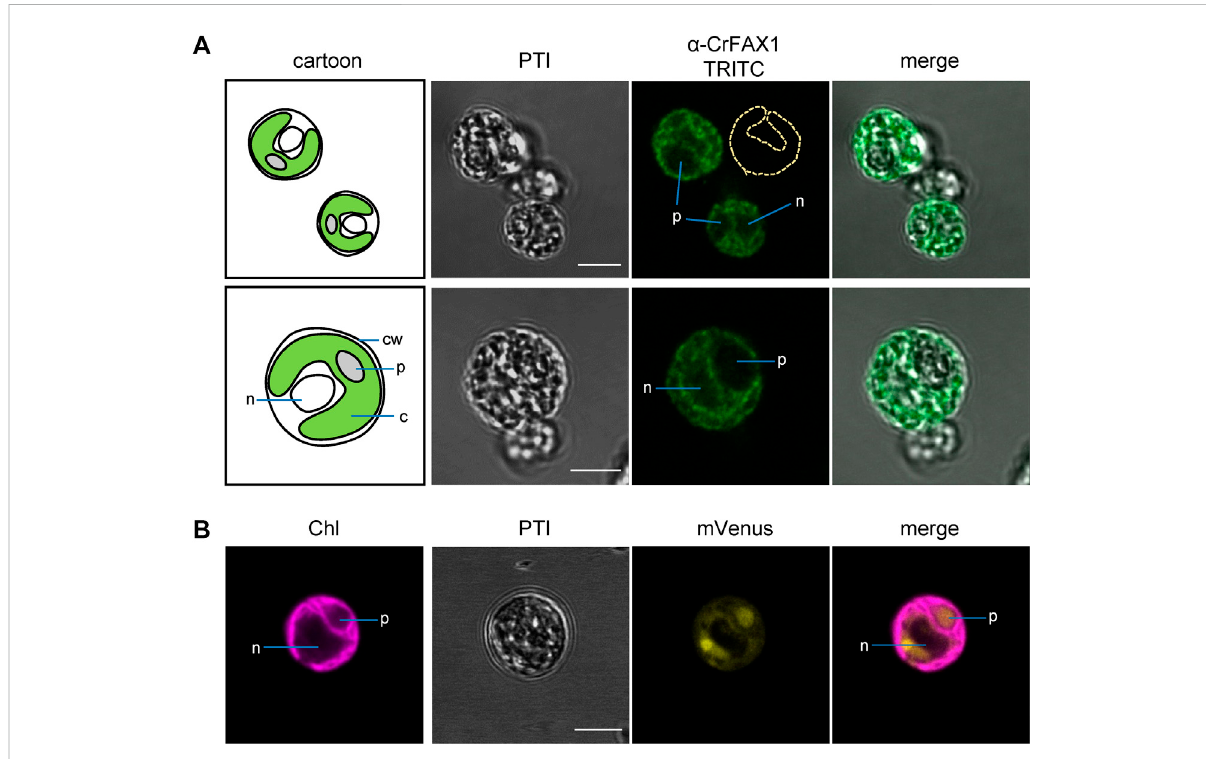
FIGURE 3 Cr-FAX1 canbefoundinthechloroplastenvelopeofChlamydomonas. (A) Insitu immuno fl uorescencesignalsof α -CrFAX1inChlamydomonas cells. Intact, fi xed wild-type UVM4 C. reinhardtii cells were treated with α -CrFAX1 antiserum and signals of the secondary antibody were detected by coupled fl uorescence of TRITC (tetramethylrhodamine-isothiocyanate). Shown are pseudo transmission images (PTI), pictures of TRITC- fl uorescence (green) and an overlay of both. A cartoon (left) illustrates positioning and organelles of the respective Chlamydomonas cells that wererecorded prior to antiserumtreatment.Location ofthechloroplast envelope anditslobes isindicatedbyayellowdashedline ( α -CrFAX1/TRITC upper panel). TRITC fl uorescence was excited at 561 nm and recorded between 565 and 583 nm by a Leica LSM780 confocal microscope. For a background control of unspeci fi c TRITC fl uorescence in comparison to chlorophyll, see Supplementary Figure S4A. c, chloroplast; cw, cell wall; n, nucleus;p,pyrenoid. (B) Fluorescencesignalsofchloroplastcontrols.Intact, fi xed C.reinhardtii cellsofanUVM4straintransformedwithanmVenus- fl uorescence construct, which is targeted to the chloroplast stroma, were examined by fl uorescence microscopy. Shown are pseudo transmission images (PTI) as well as chlorophyll (purple) and mVenus (yellow) fl uorescence and an overlay of both. (mVenus: excitation at 514 nm, emission at 520 – 564 nm; chlorophyll: excitation at 458 nm, emission at 626 – 735 nm; Leica LSM780 confocal microscope). Note that the soluble mVenus construct in (B) shows signals in the chloroplast stroma and the pyrenoid, while chlorophyll fl uorescence (B) and α -CrFAX1 signals in (A) only appear at thylakoid and envelope membranes, respectively. All scale bars are 5 μ